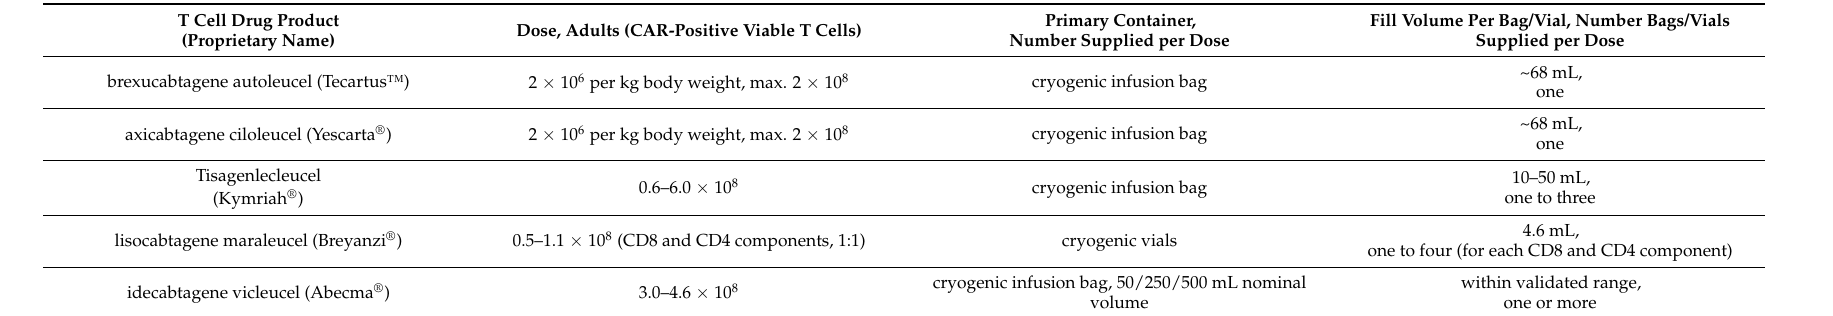
Table 1. Comparison of dose and fill across marketed T cell drug products [10–14].